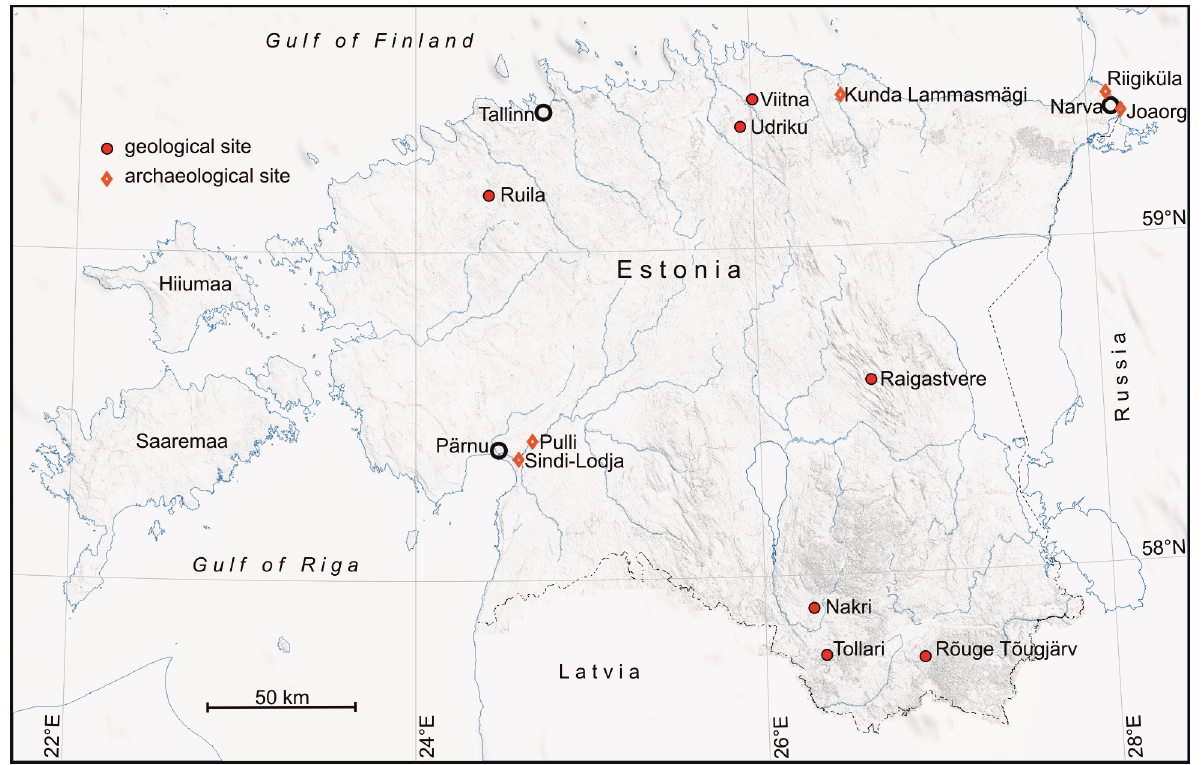
Fig. 2. Map of Estonia with location of sites discussed in the